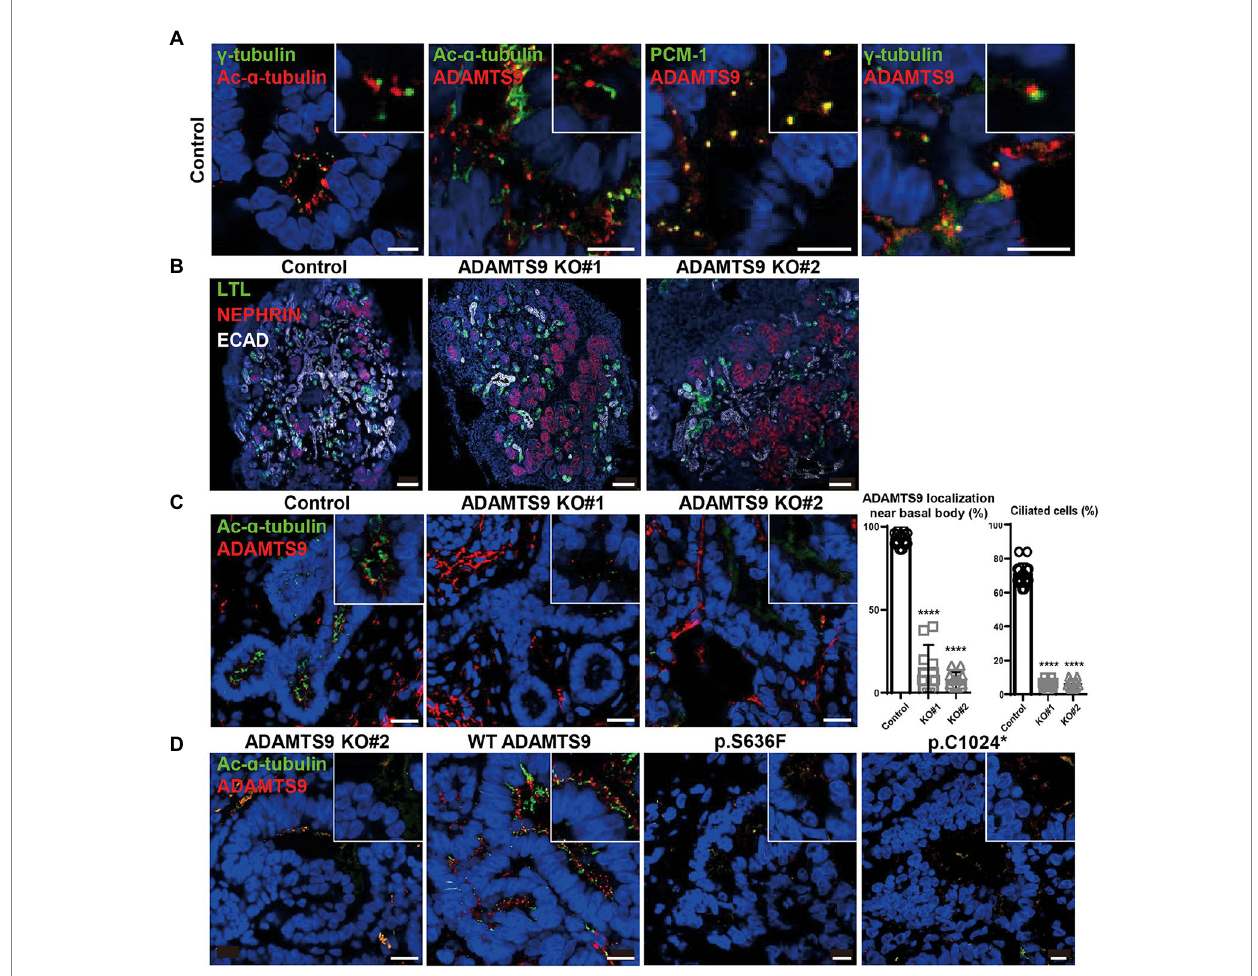
FIGURE 2 ADAMTS9 knockout kidney organoids demonstrate abnormal cilia, and ciliogenesis is not rescued by overexpressing ADAMTS9 variants. (A) ADAMTS9 is localized near the basal bodies of primary cilia and co-localized with PCM-1. The organoids were stained with anti-ADAMTS9, anti-Ac- α -tubulin, anti-PCM1, or anti- γ -tubulin antibodies. Scale bar, 10 μ m. (B) Immunofluorescence staining of the kidney organoids displaying different structures, including the glomerulus (NEPHRIN), proximal tubules (LTL), and distal tubules (ECAD). Scale bar, 100 μ m. (C) Loss or shortening of primary cilia was observed in ADAMTS9 knockout organoids. Percentage of ciliated tubular cells in kidney organoids and quantification of cilium length on the basis of Ac- α -tubulin staining are shown in the right panel. Data represent means ± standard deviation (SD). Scale bar, 10 μ m. **** p < 0.0001. (D) Ciliogenesis was rescued by overexpressing wild-type but not by mutant forms of ADAMTS9, in ADAMTS9 -ablated kidney organoids. Scale bar, 10 μ